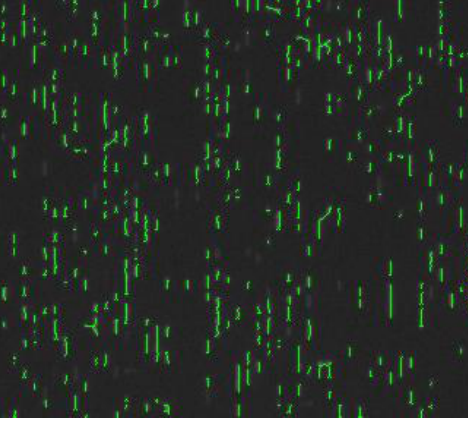
Figure 6. P . aeruginosa attachment to 0.75 µm spaces in a silicone-based 0.75 µm line/0.75 µm space